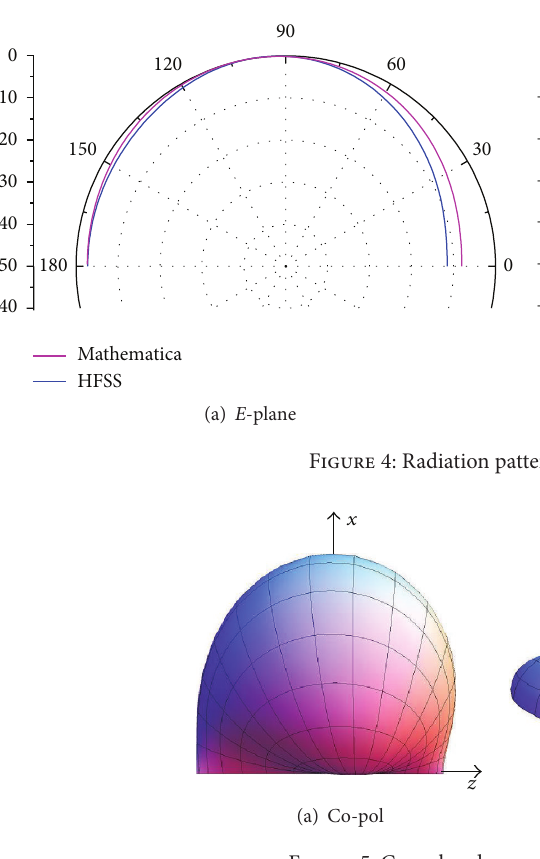
Figure 5: Co-pol and cross-pol 3D radiation patterns.